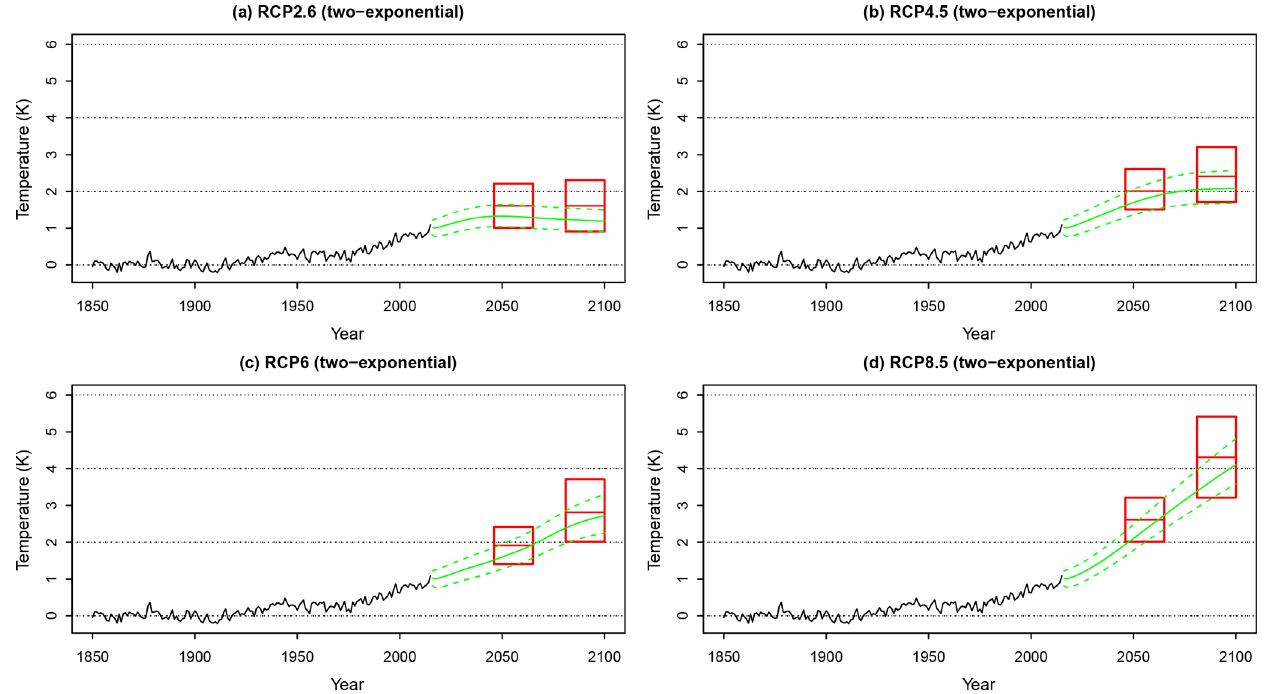
Figure 6. Panels (a) – (d) describe the marginal posterior means and 95% credible intervals of the predicted temperature response to fu- ture forcing according to the RCP2.6, RCP4.5, RCP6, and RCP8.5 trajectories, respectively, using a mixture of two-exponential response functions. These are compared to the AR5 projections (black boxes).